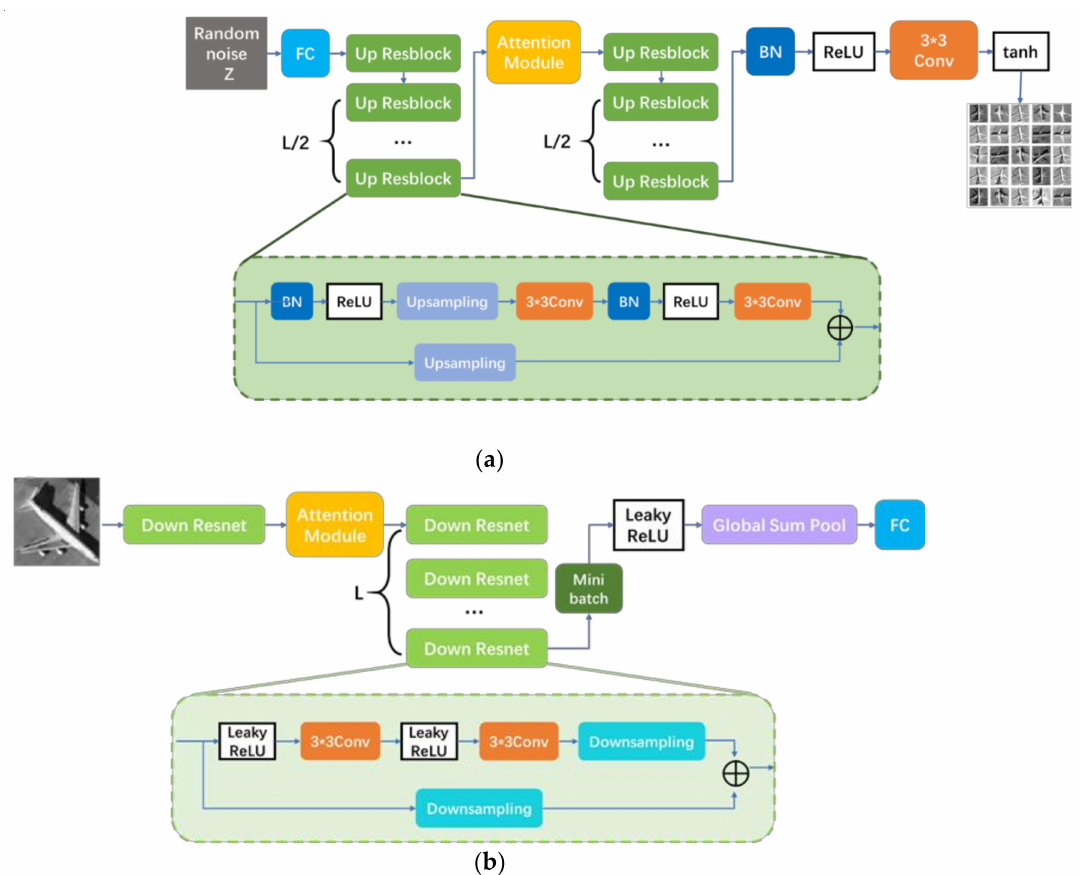
Figure 2. The structure of the Shuffle Attention GAN; ( a ) the structure of the generator; ( b ) the structure of the